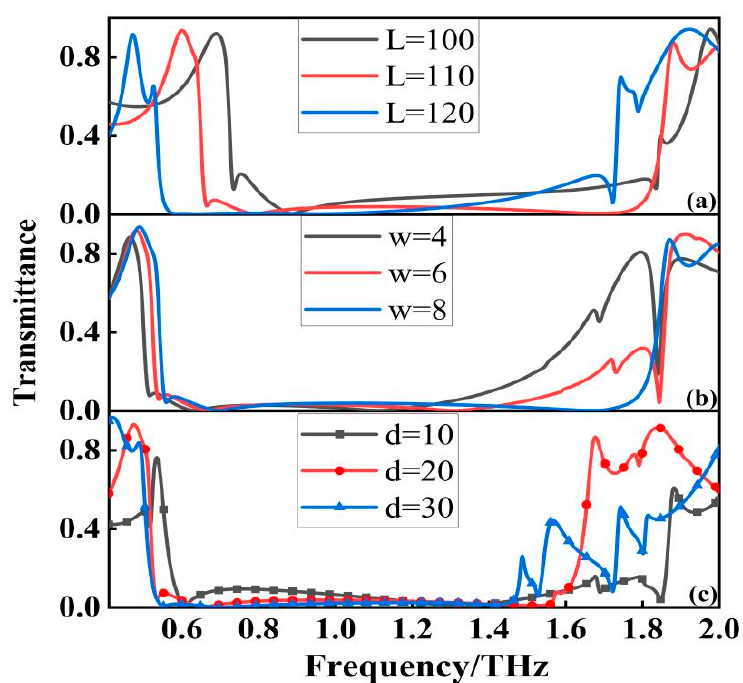
Figure 3. Transmittance spectra at different geometric parameters: ( a ) L = 100, L = 110 and L = 120; ( b ) w = 4, w = 6 and w = 8; ( c ) d = 10, d = 20 and d = 30.